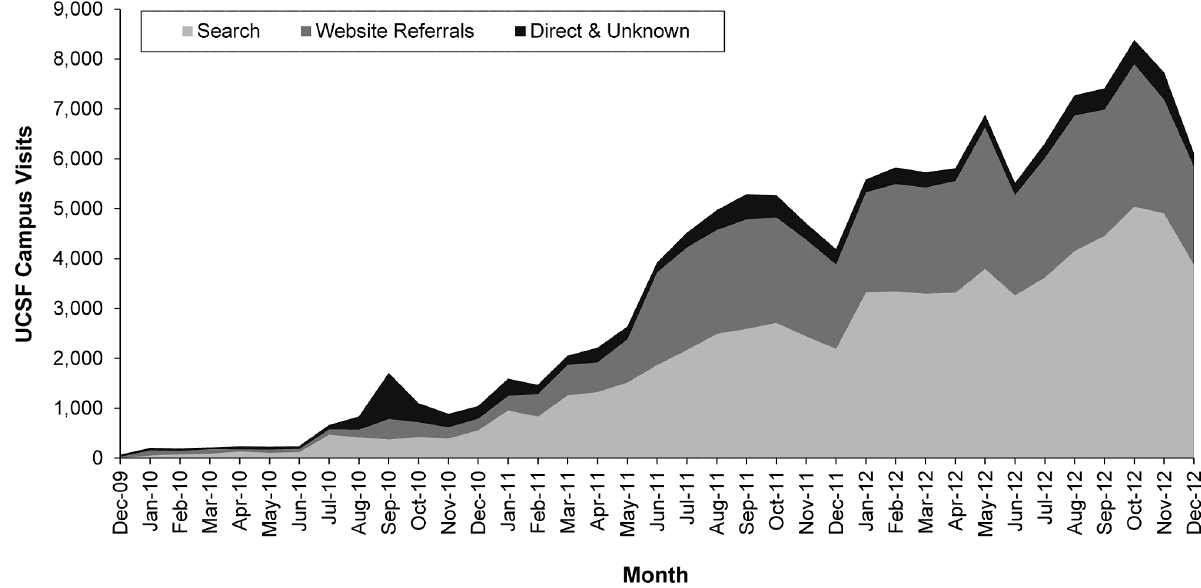
Figure 3. Time course of growth in traffic from various referral sources (peak in direct traffic in September 2010 coincides with launch activities at